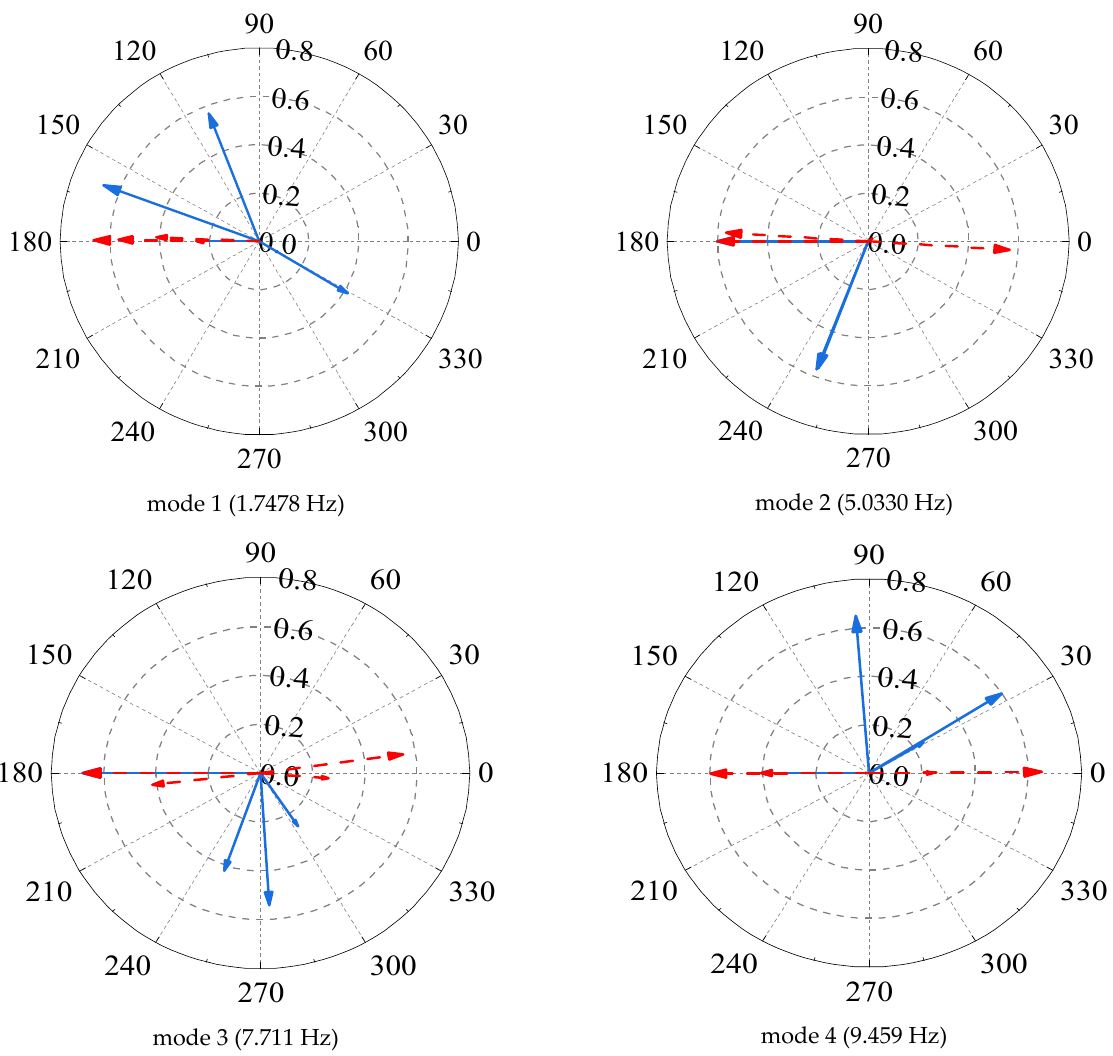
Figure 5. Comparison of theoretical and estimated mode shapes in complexity. (The red dash lines refers to the theoretical mode shapes whereas the blue lines refers to the estimated mode shapes). In order to find actual lags, Figure 6 displays the first-order singular value obtained from FDD-FSP. Recalling Equation (20), the computational parameters are as follows: the step size (2 p + 1) is set as 121, the order of exponentiation ( m ) is set as 50, the frequency convergence threshold ( δ ) is set as 1 × 10 − 6 , and the total iteration number is 1000. The spectrum is concentrated at the true position of natural frequency. The advantage of FSP is the reduction of distortion in the target frequency pickup and the improved estimation accuracy of the delay (Equation (14)). To exemplify this, a zoomed-in view of Figure 6 is shown. It is clear that the original first-order spectral line moves to the target peak where the 1st to 4th order frequencies are well-reflected.